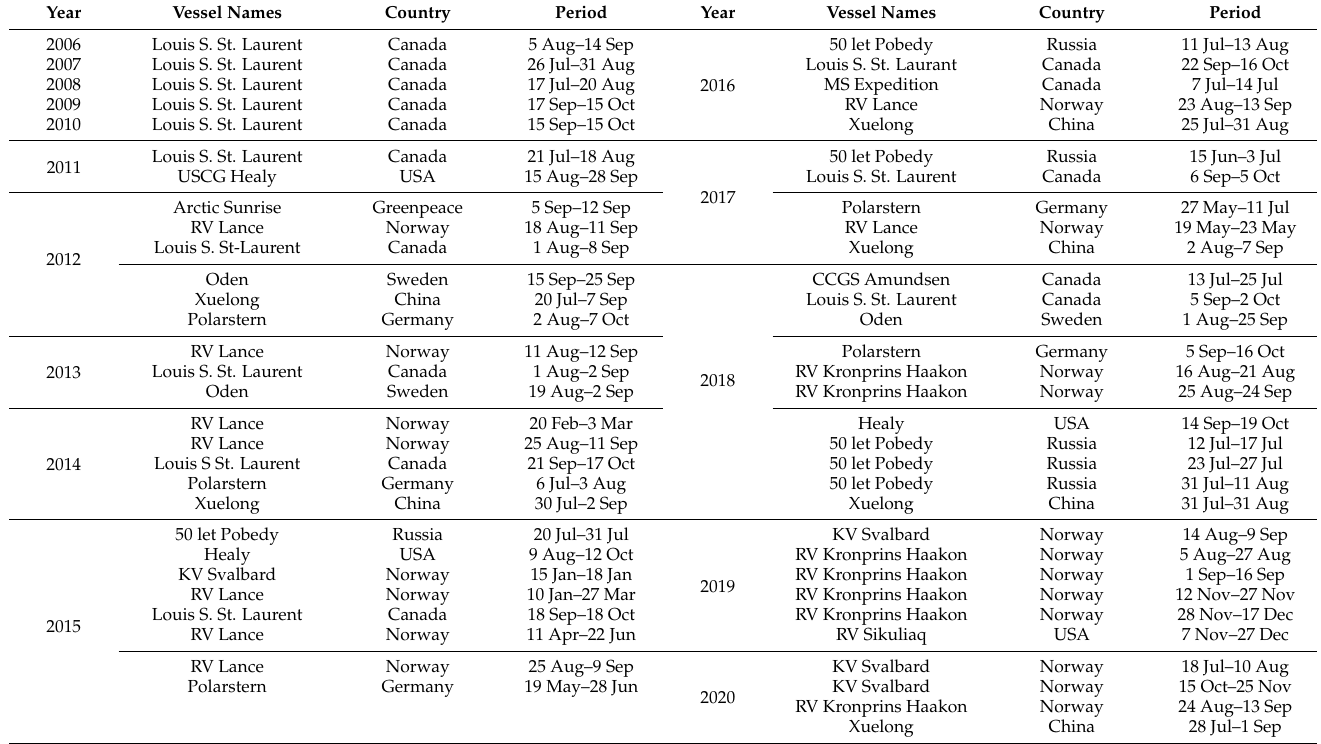
Table 1. A list of the 60 Arctic cruises used in this study from Ice Watch and Xuelong I/II, including the cruise year, vessel names, flag country, and ship-based observation